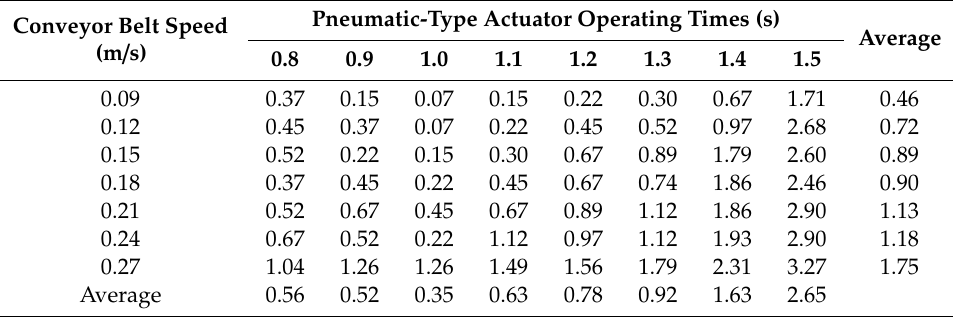
Table 4. Empty rate of pot tray cells (unit: